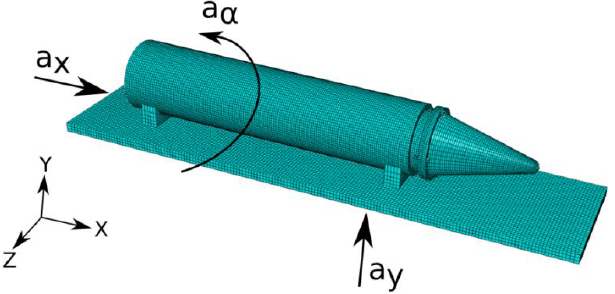
Figure 6. Loads of the missile vehicle.